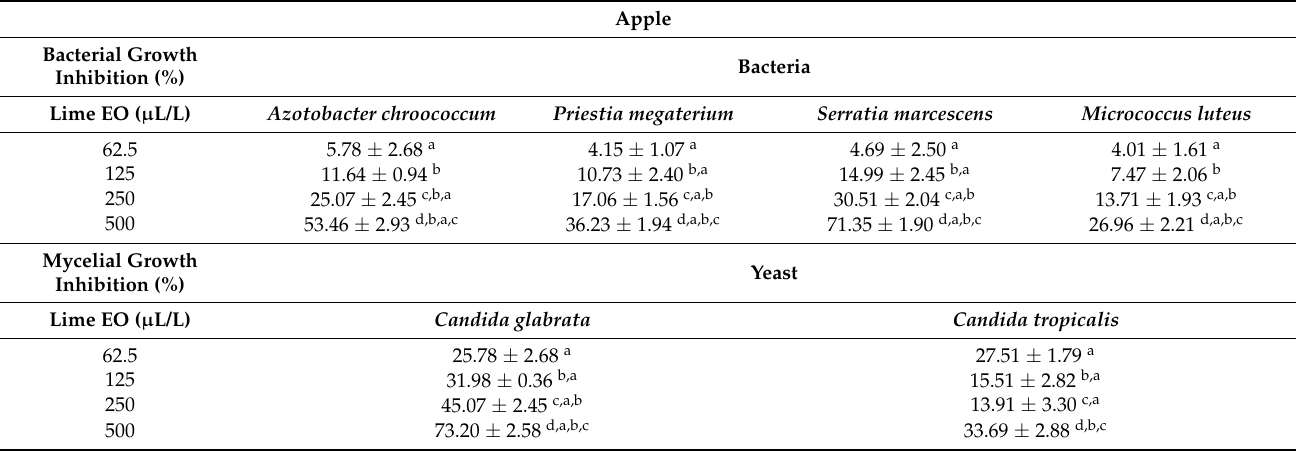
Table 3. In situ analysis of the antibacterial activity of the vapor phase of CAEO in apple. Apple